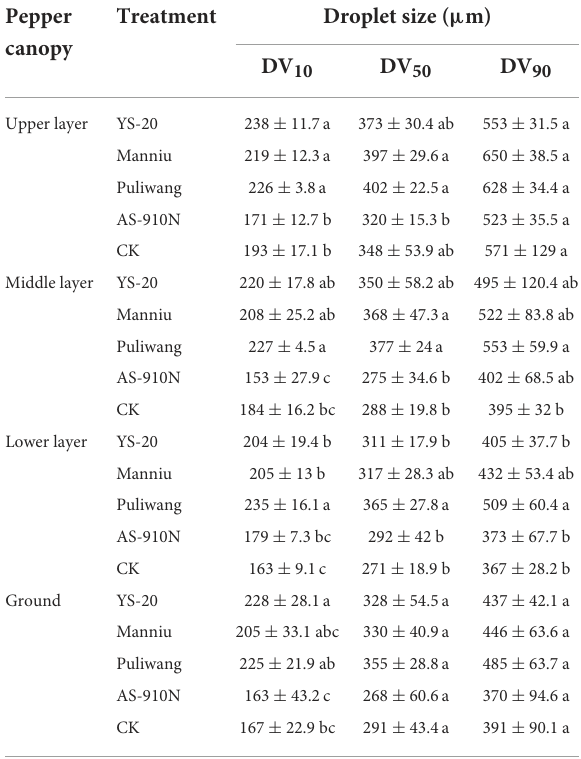
improve the spreading rate of defoliant droplets on pepper leaves and improve the defoliation effect.